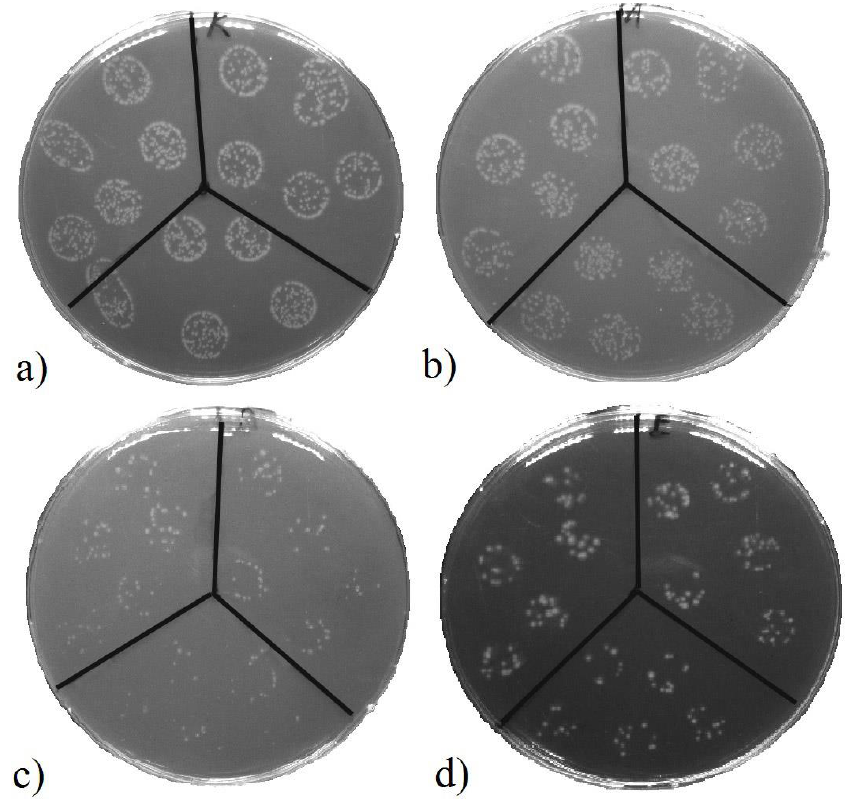
Figure 13. Growth reduction of E. coli on evaluated samples after 2 h of incubation. Images of agar plates with E. coli colony-forming units. ( a ) Control (incubated only in physiological solu- tion); ( b ) Pristine (PLLA); ( c ) Unheated sample with 5 and 25 nm of Au and Ti layers, respectively; ( d ) Heated sample with 5 and 25 nm of Au and Ti